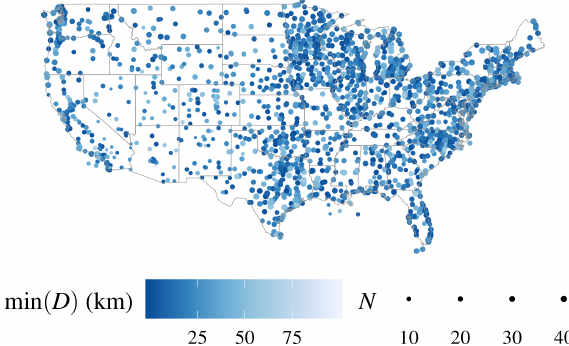
Figure 1. ASOS ceilometers used for CBASE z evaluation. The size of the marker indicates the number of satellite–ceilometer z coincidences during the year 2007. Color indicates the closest co- location distance achieved in